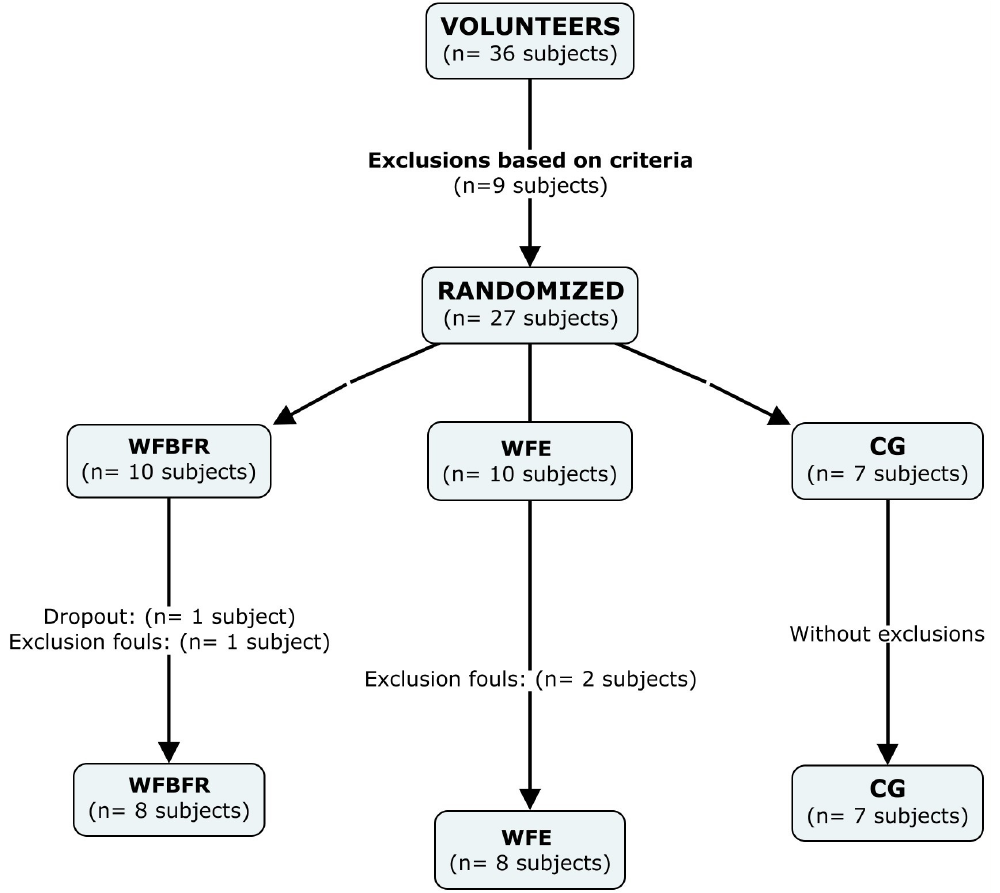
Figure 1. Organization Chart of the